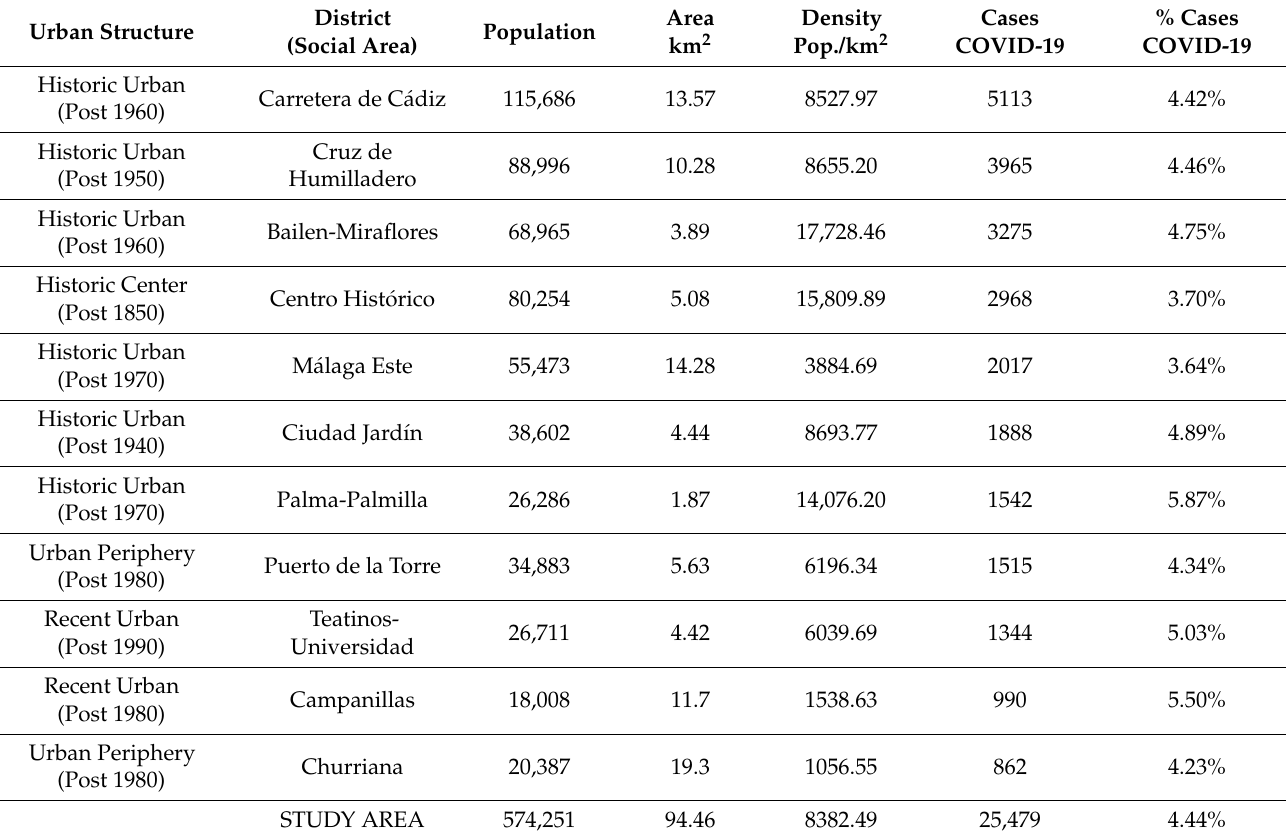
Table 1. Summary table of the characteristics of the urban structure (Ordered by descending number of COVID-19 cases). Source: Municipal Register of Inhabitants (National Institute of Statistics [INE] Government of Spain), year 2020, and Information Management of the Andalusian Health Service (SAS) Regional Government (Spain). Cases from 5 March 2020 to 31 March 2021. We have preferred to keep the locally known name for the district for better